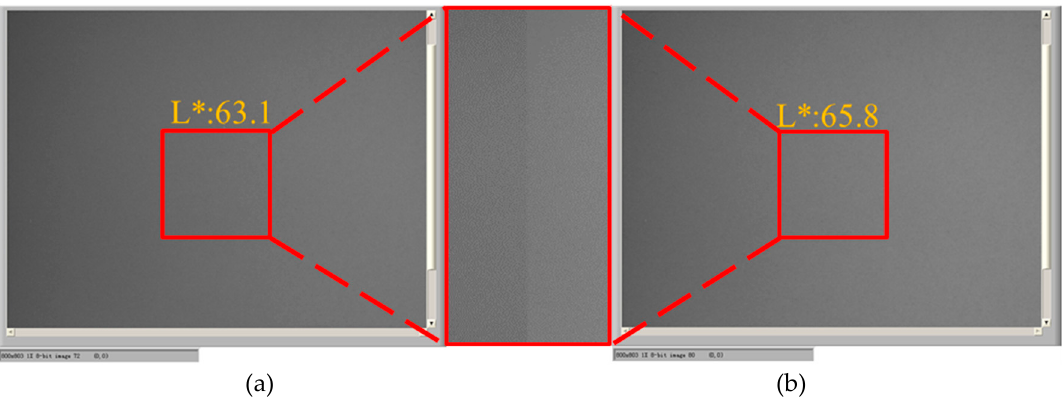
Figure 13. Comparison of the white reference grayscale. ( a ) An EPD was driven to white grayscale by the conventional driving waveform. ( b ) An EPD was driven to white grayscale with the proposed driving waveform.